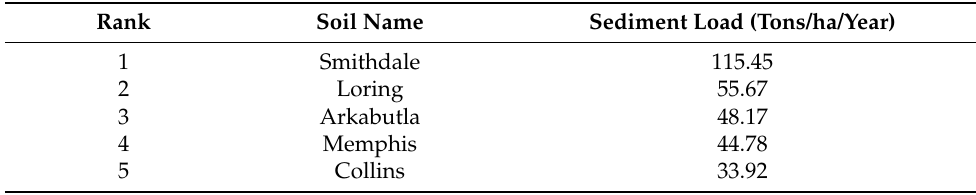
Table 5. Sediment load of predominant soils throughout the